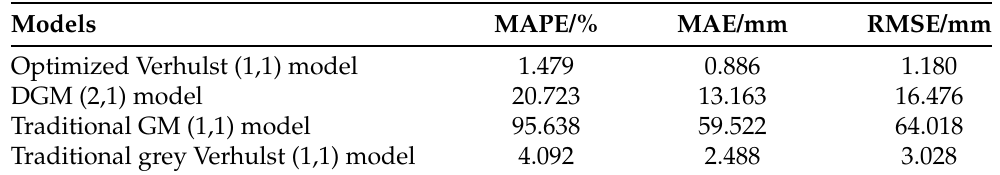
Table 4. The accuracy comparison between predicted and actual value of four models for